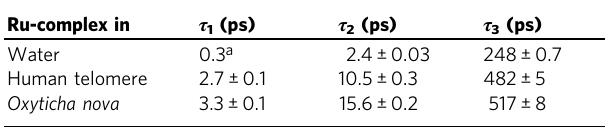
Table 2 Time constants for ultrafast excited state decay processes of [Ru(phen) 2 dppz] 2 + in water and in G- quadruplexes, obtained from global fi t of fs transient absorption data.